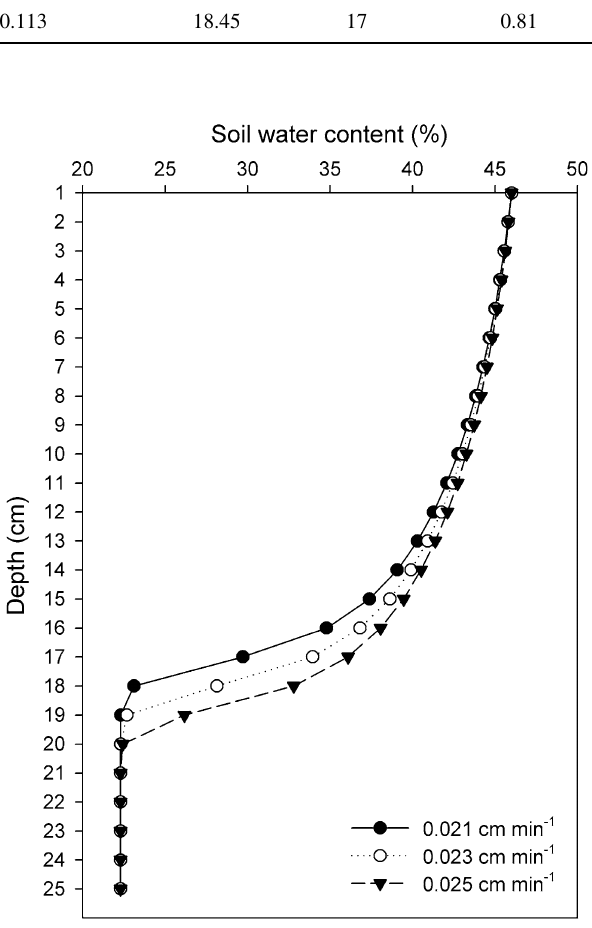
Table 6 Measured and simulated times ( tp ) and RMSEs for simulated values and measured values of for natural rainfall events Rainfall intensity (mm/min)